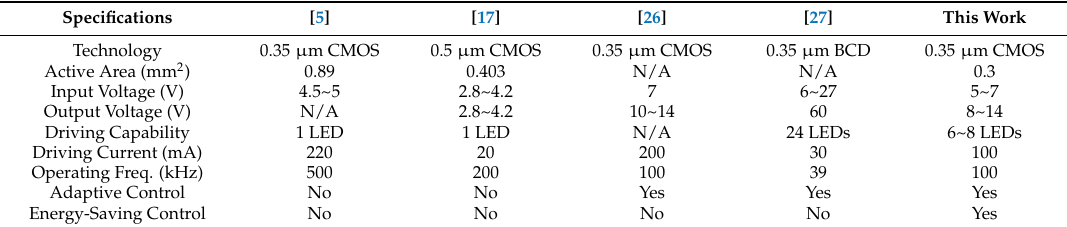
Figure 13. Chip microphotograph. Table 1. Performance